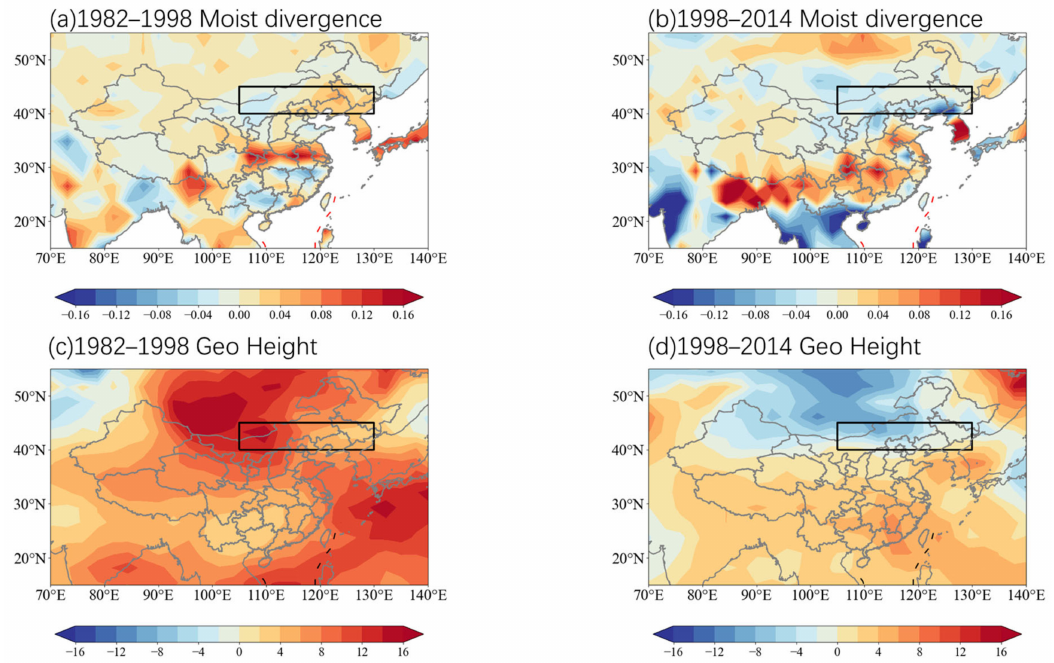
Figure 12. Trends of column-integrated moisture divergence (upper row, shading, positive is conver- gence and negative is divergence, units: 10 − 5 kg/s · m 2 /a) and 500 hPa geopotential height (bottom row, units: m/a) in JJA. Note: warm tones represent an increasing trend, cool tones represent a decreasing trend. The black dashed lines in the figure represent Ten-dashed lines. The numbers below the description of the colors represent the trend slope value. The black box in it is defined as the northeastern region of East Asia (40~45 ◦ N, 105~130 ◦